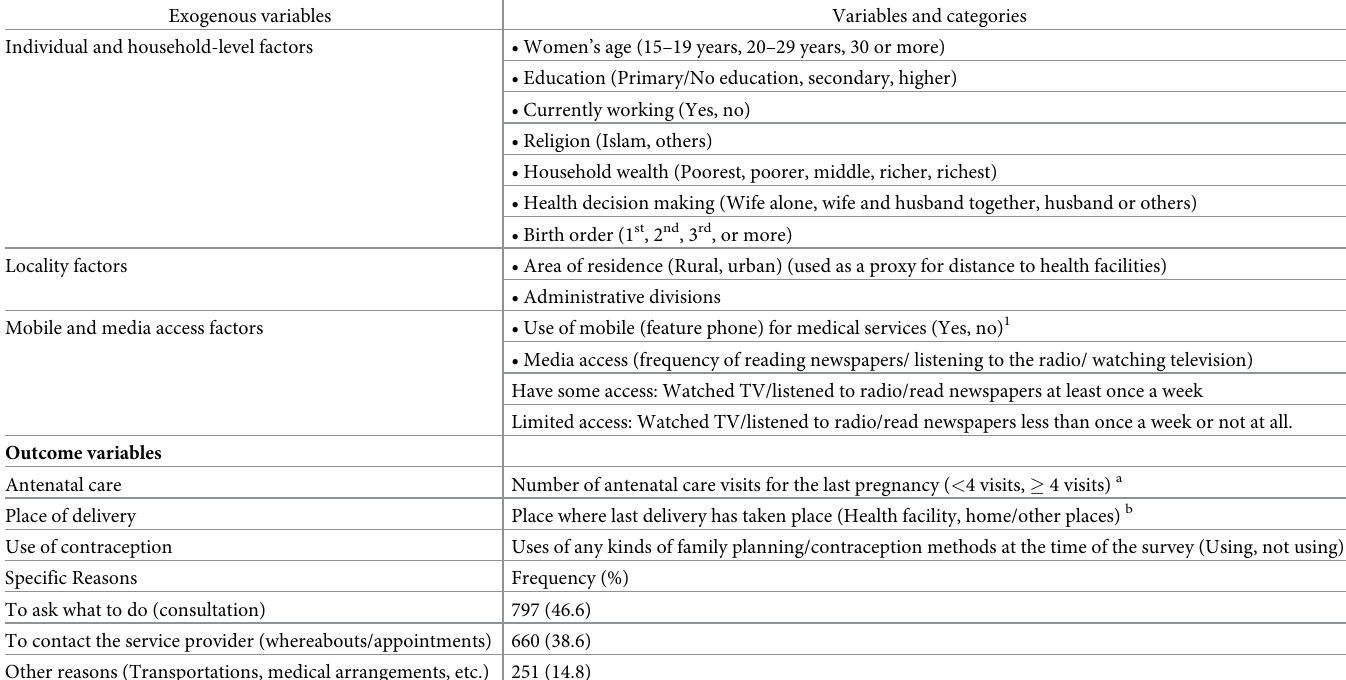
Table 1. Description of exogenous and outcome